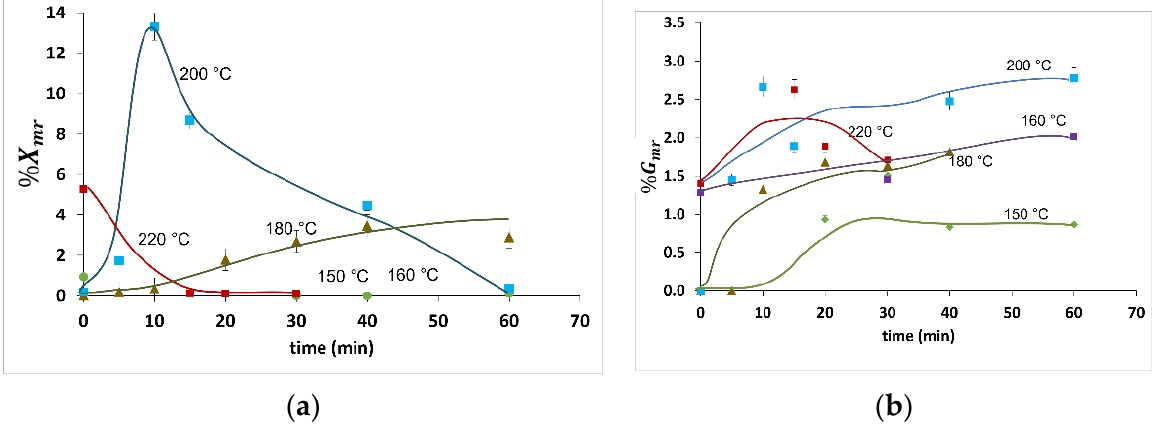
Figure 2. Polymers release to monomers as a function of isothermal reaction time and temperature of